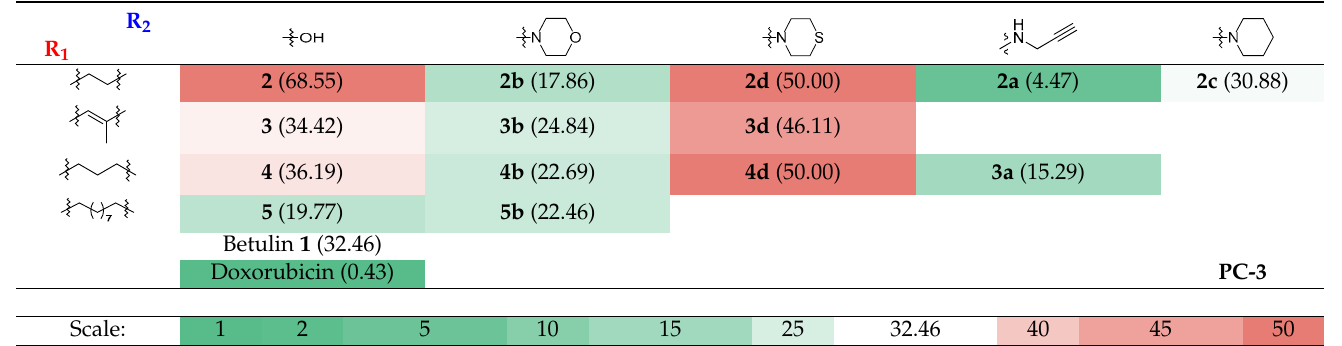
The color scheme visualizes active compounds in green and inactive ones in red. Color saturation corresponds to their degree of activity as indicated on the scale.